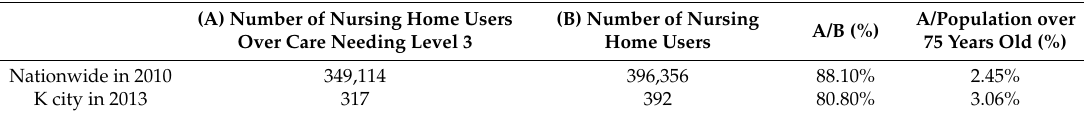
Table 6. Ratio of users of nursing homes over care needing Level 3 (resource of nationwide data is